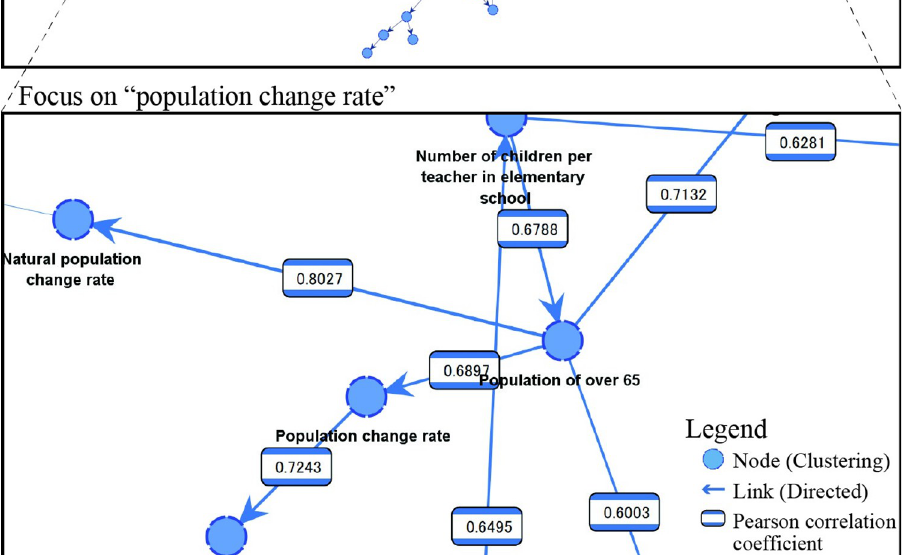
PLOS ONE | https://doi.org/10.1371/journal.pone.0284134 April 10,